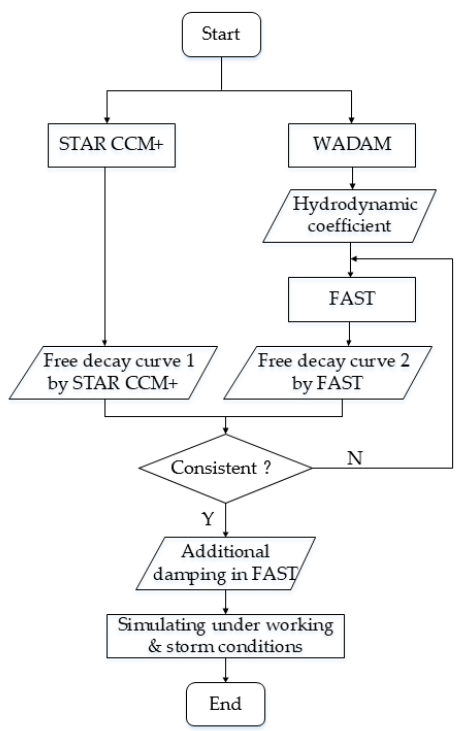
Figure 1. Numerical simulation procedure.